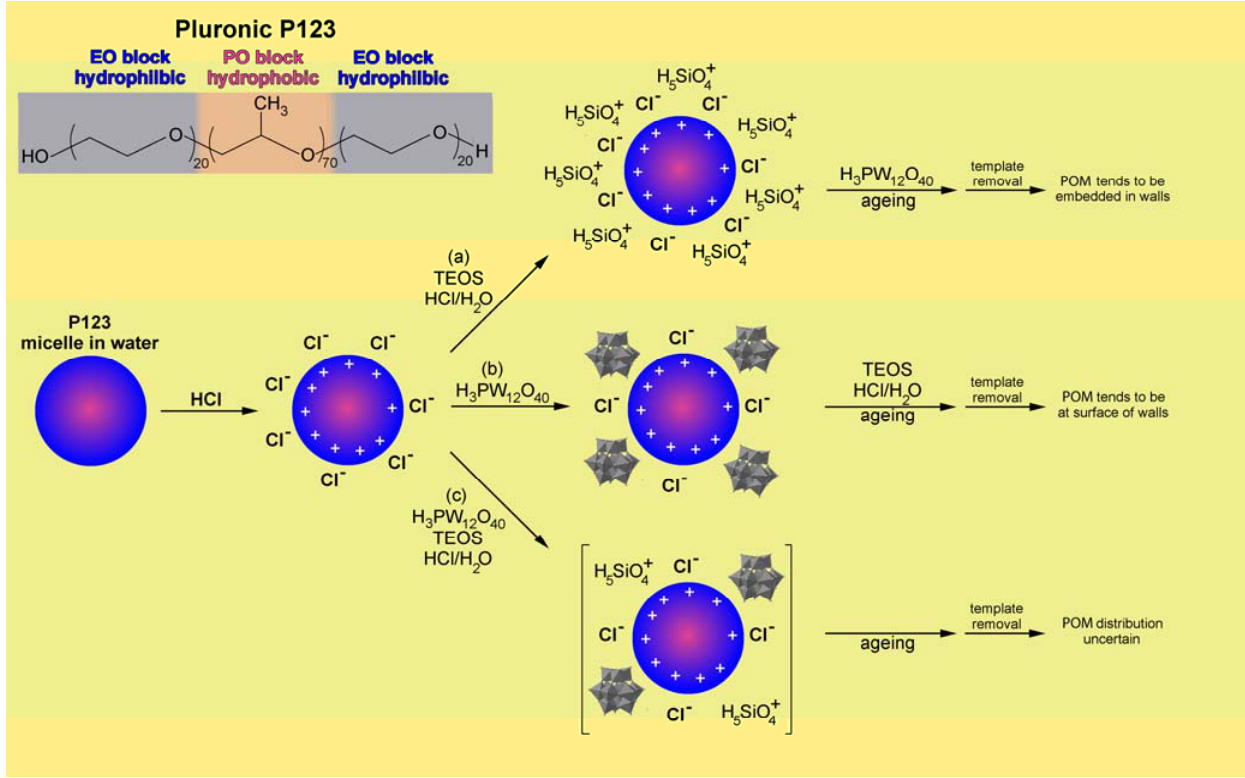
framework of SBA-15 type silica: (a) Prehydrolysis of TEOS in the presence of